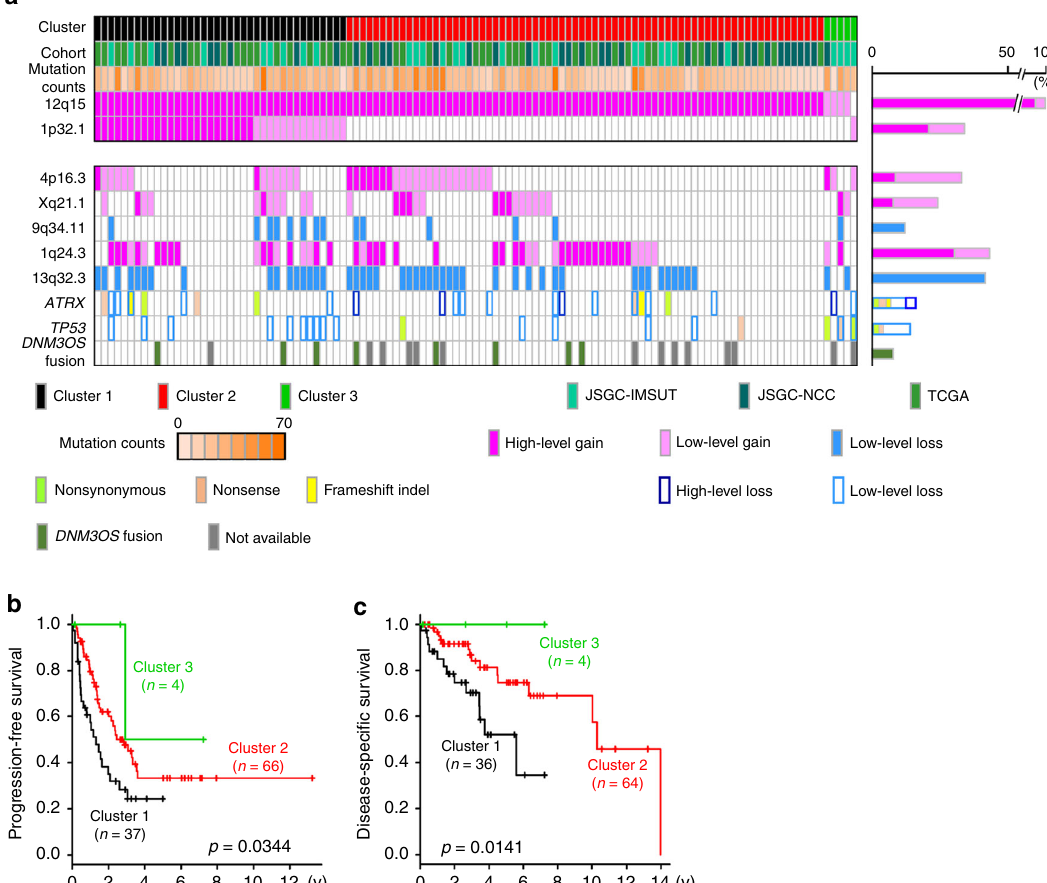
Fig. 3 Mutational landscape of DDLPS and survival analysis by genomic clustering. a Mutational landscape of DDLPS. The status of the SCNAs, which were independently associated with disease-speci fi c or progression-free survival, TP53 and ATRX driver mutations, and DNM3OS -fusion genes is depicted in the landscape. Clustering was performed based on the SCNA status of 1p32.1 and 12p13.32 in DDLPS with a high-level gain of 12q15. The bar graph on the right side represents the ratio of the affected samples to all examined samples. b , c Impact of genomic clustering on disease-speci fi c ( b ) and progression-free ( c ) survival of patients with DDLPS. Disease-speci fi c and progression-free survival was analyzed using Kaplan – Meier methods. P -values derived from log-rank analysis are included on each